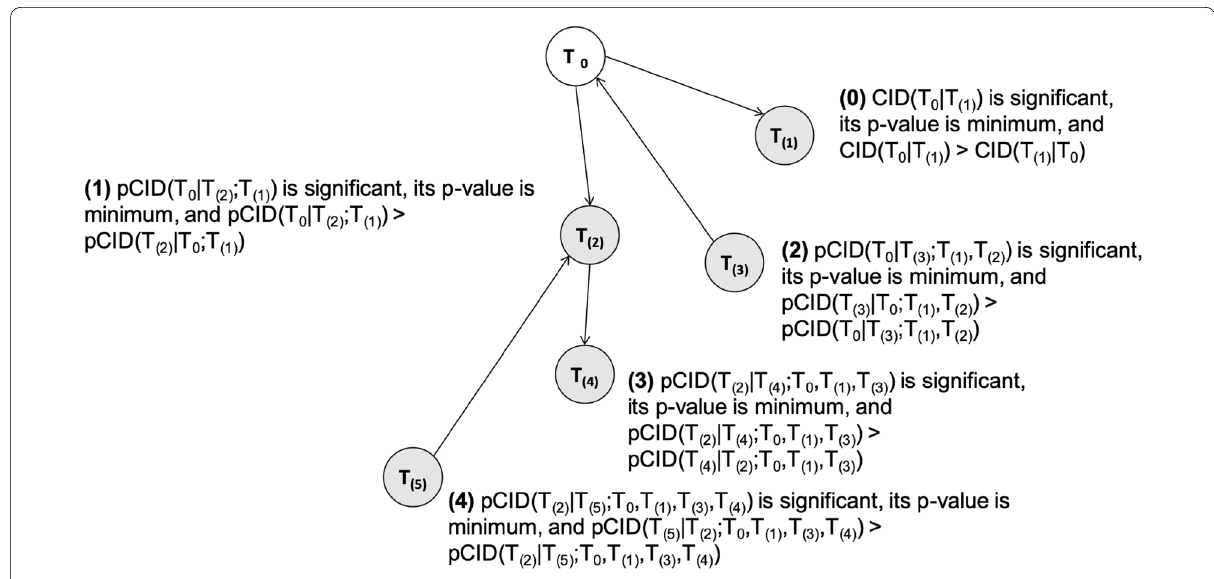
Fig. 2 Illustration of the heuristic approach for regulation path